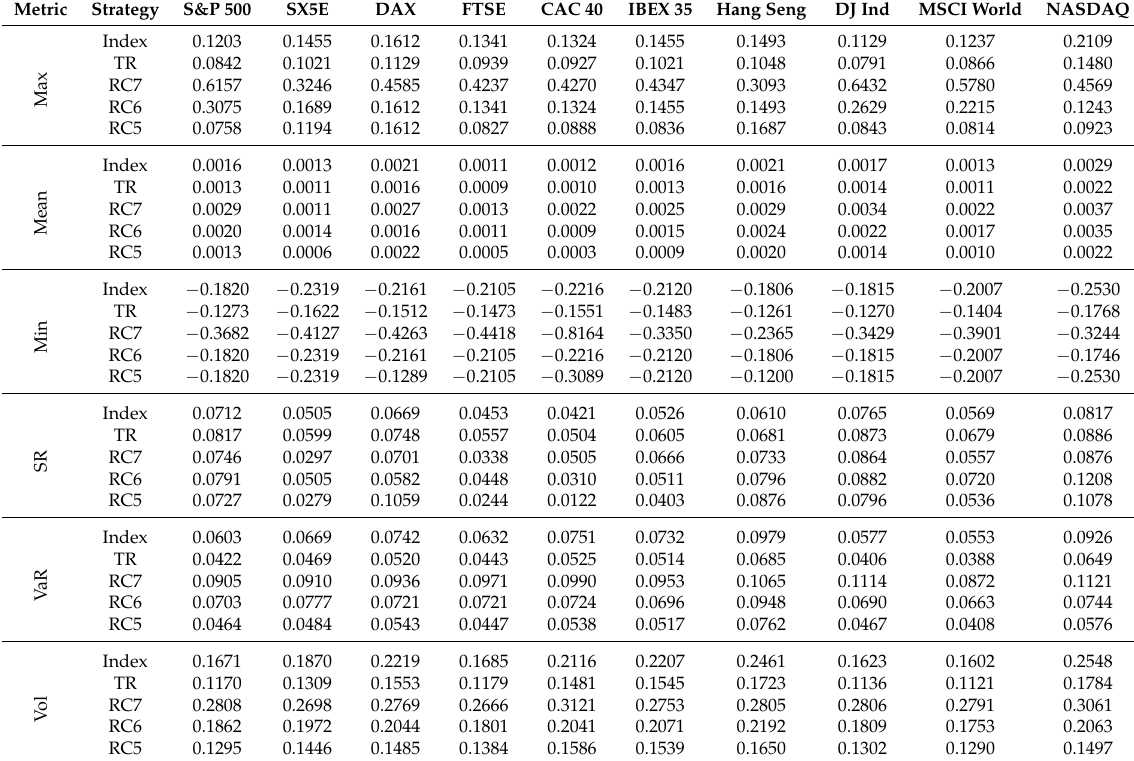
Table 3. Results of the SRRI-based trading strategy. If the realized volatility of the strategy falls outside the range defined by the risk class, the exposure is altered by a trading rule based on volatility buckets. The table shows the mean values for the respective metric of the strategies applied to weekly returns for the period from 13 September 1991–27 February 2015. For reference purposes, we also added the results for the index itself, representing a passive investment and a traditional 70/30 strategy (TR). The highest mean returns are obtained for Risk Class 7 (RC7), whereas a diverse pictures is shown regarding the SRs (Sharpe Ratios) with no risk class clearly